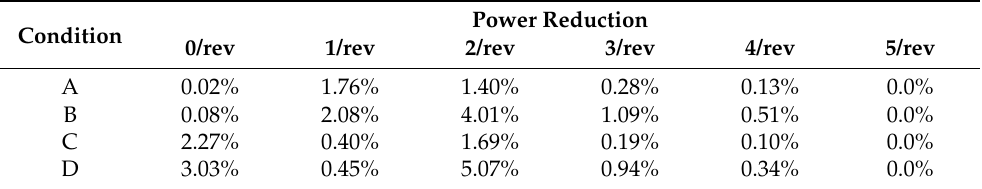
Table 3. Rotor power reduction using uniform twist control with single-harmonic inputs.